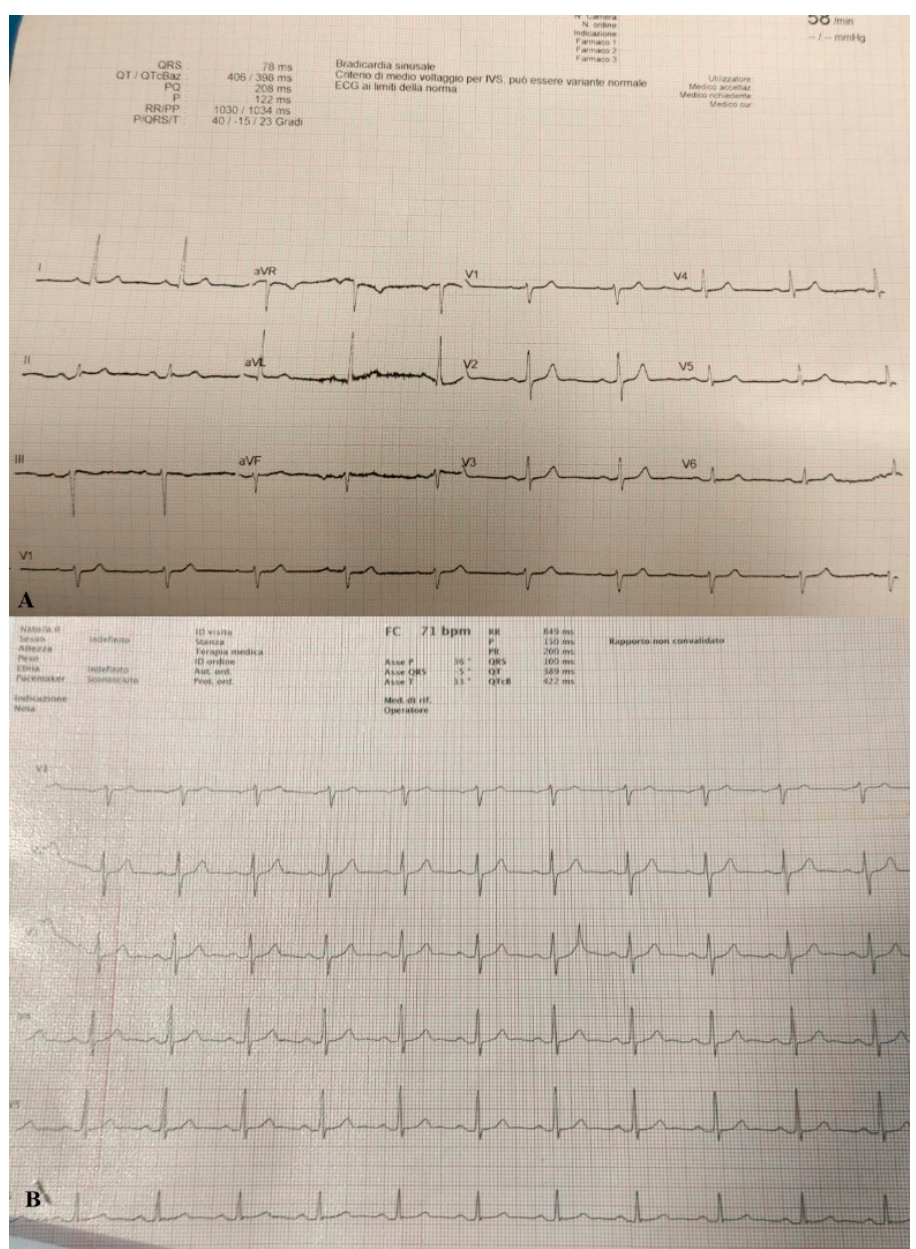
Figure 2. ( A ) EKG performed on admission. ( B ) EKG performed when pneumopericardium was